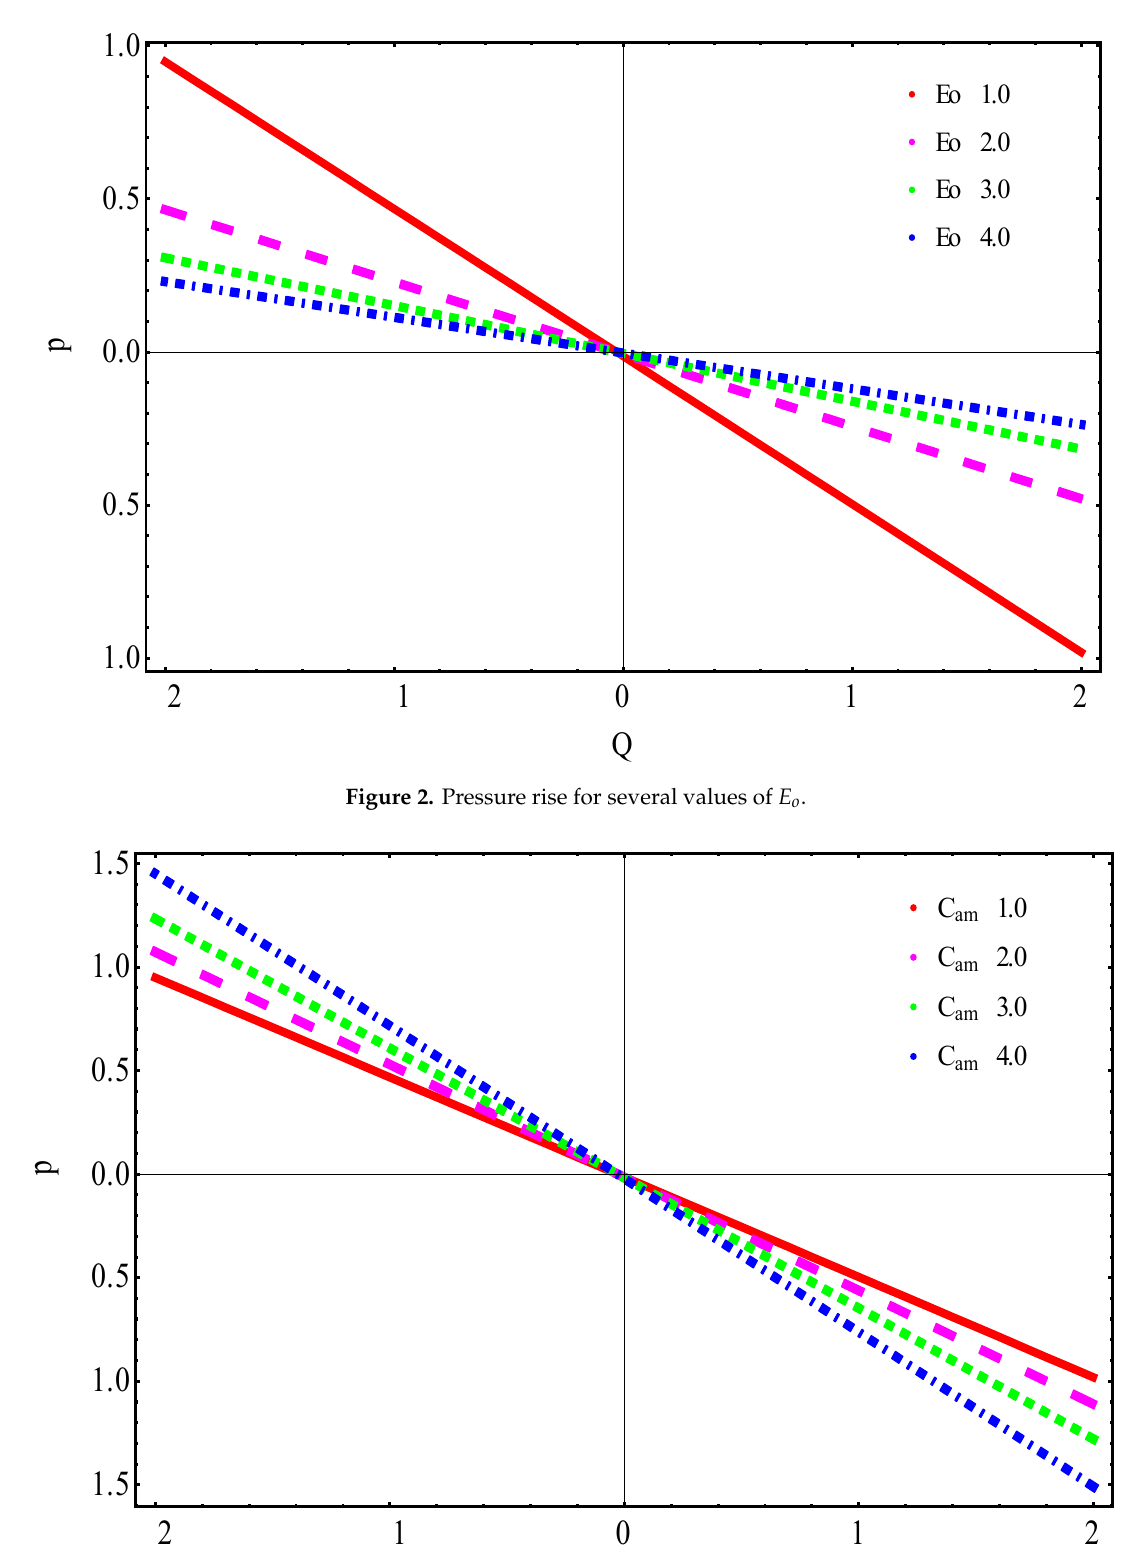
Figure 3. Pressure rise for several values of 𝐶 (cid:3028)(cid:3040) .